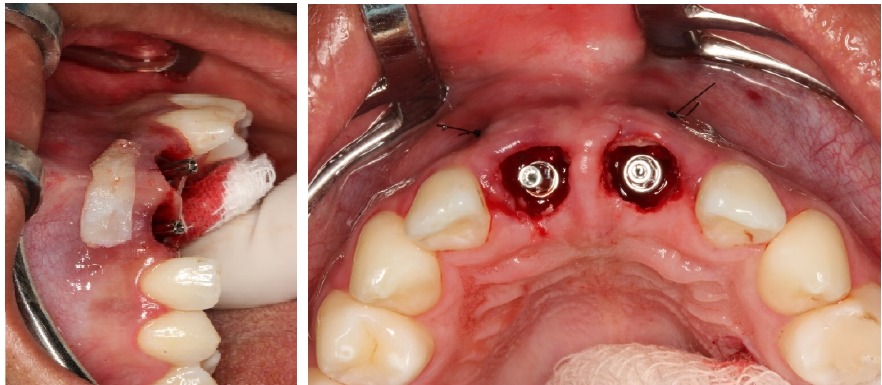
Figure 9. Connective tissue’s placement and installation.